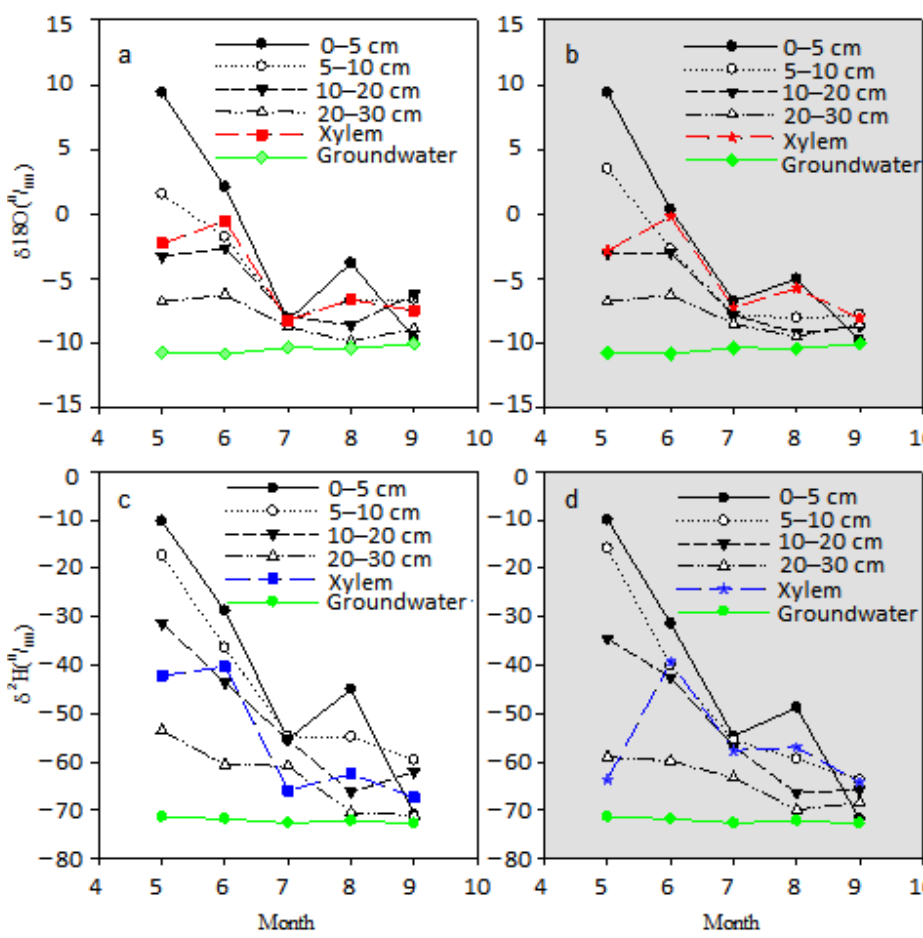
Figure 6. Monthly trends of δ 2 H and δ 18 O of soil water, xylem water and groundwater. Variation in δ 18 O ( a , b ) and δ 2 H ( c , d ) in soil water, xylem water and groundwater from May to September. The white area indicates the Bromus inermis grassland and the gray area indicates the Medicago sativa grassland.